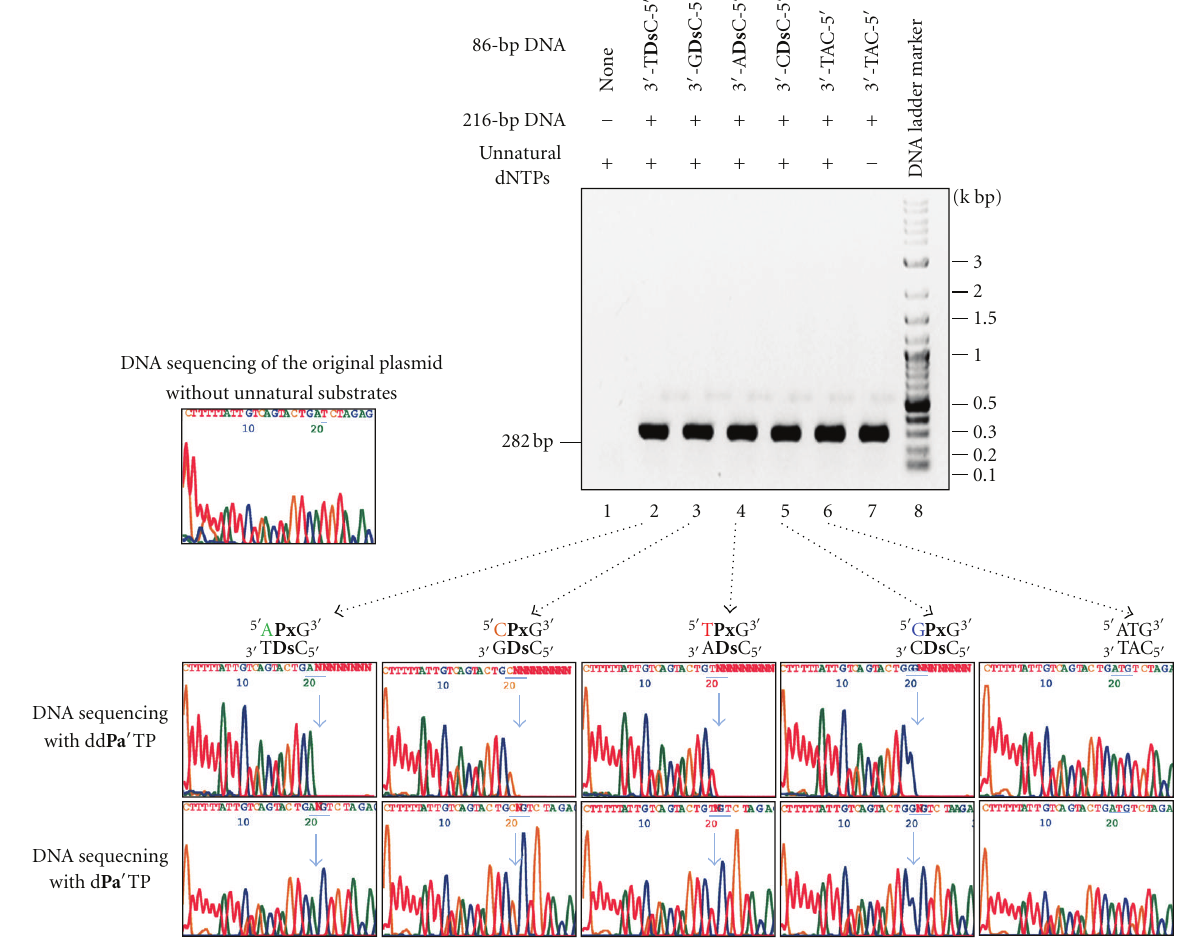
Figure 3: PCR amplification and DNA sequencing of 282-bp DNA templates containing Ds at specific positions. After 25-cycle fusion PCR using the P1 and P4 primers and the 86-bp and 216-bp DNA fragments as templates in the presence or absence of d Ds TP and Diol1-d Px TP, the amplified PCR products were analyzed on a 1% agarose gel. Using the purified PCR products, the sequencing reactions were performed in the presence of dd Pa (cid:3) TP (upper sequencing panels) or d Pa (cid:3) TP (lower sequencing panels). The light blue arrow indicates the unnatural base position. The light blue bar indicates the inserted